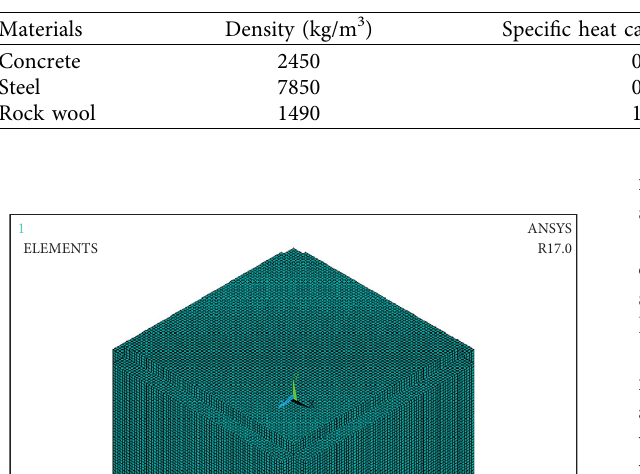
Figure 6: Comparison of test specimen strength results. Table 4: Thermal parameters of materials.